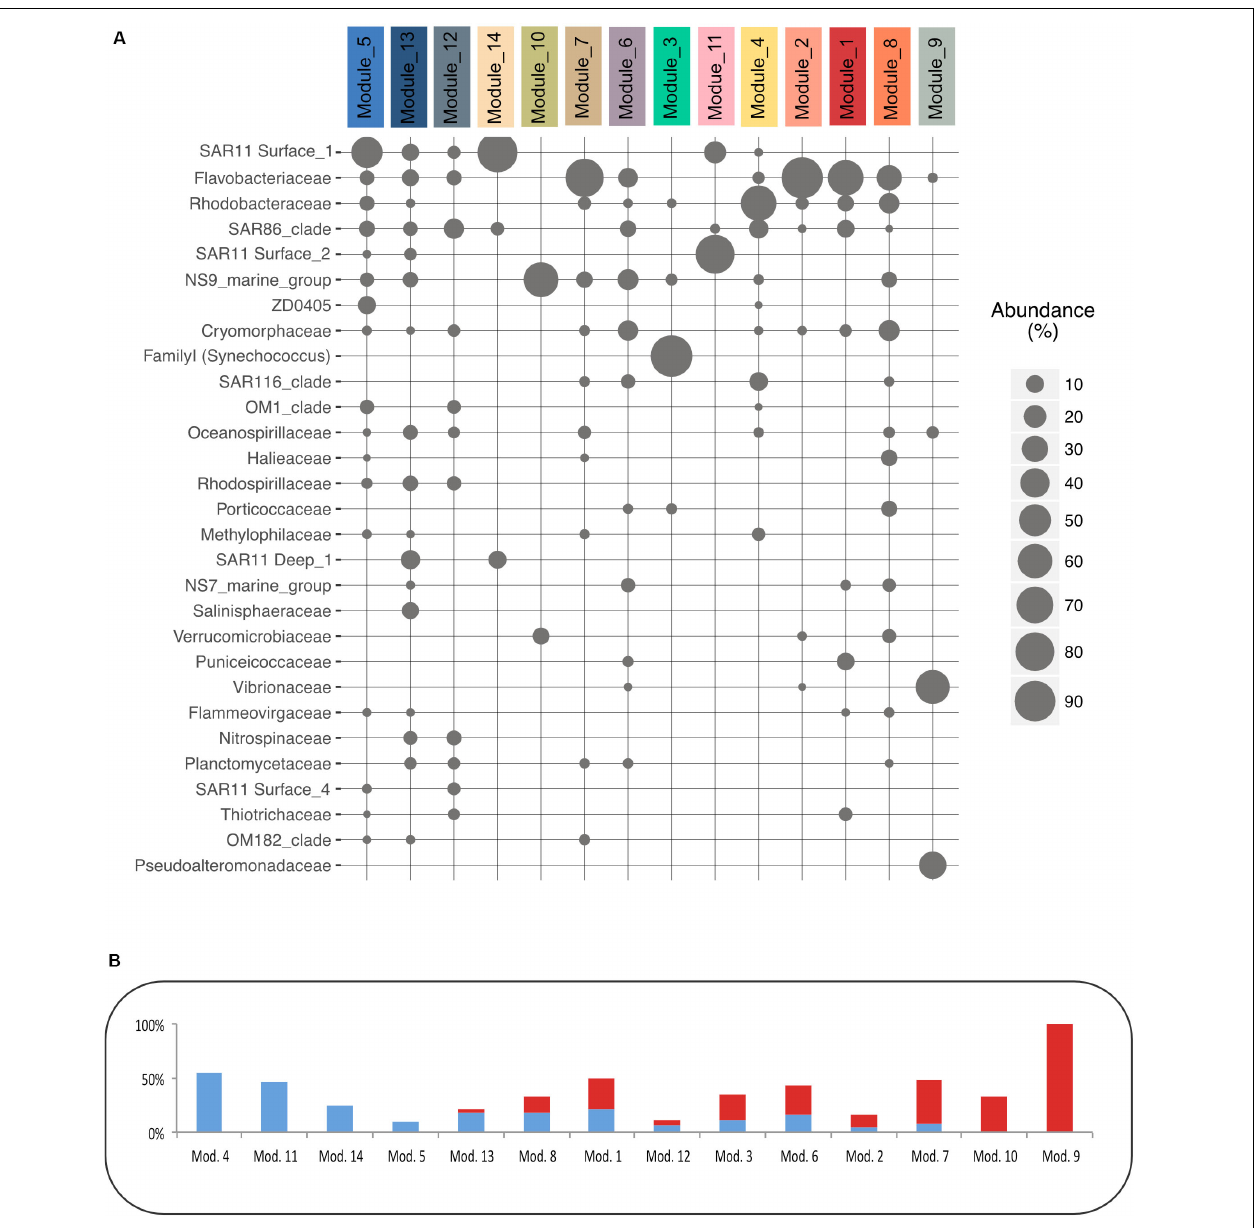
FIGURE 4 | Modules’ taxonomy and Coefficient of Variation of their OTUs. (A) Relative abundance of the 30 main families in each module. (B) Proportion of OTUs (in% of all the OTUs in a module) that present a High Coefficient of Variation (HCV) in red, or a Low Coefficient of Variation (LCV) in blue defined based on Newton method (Newton and Shade,